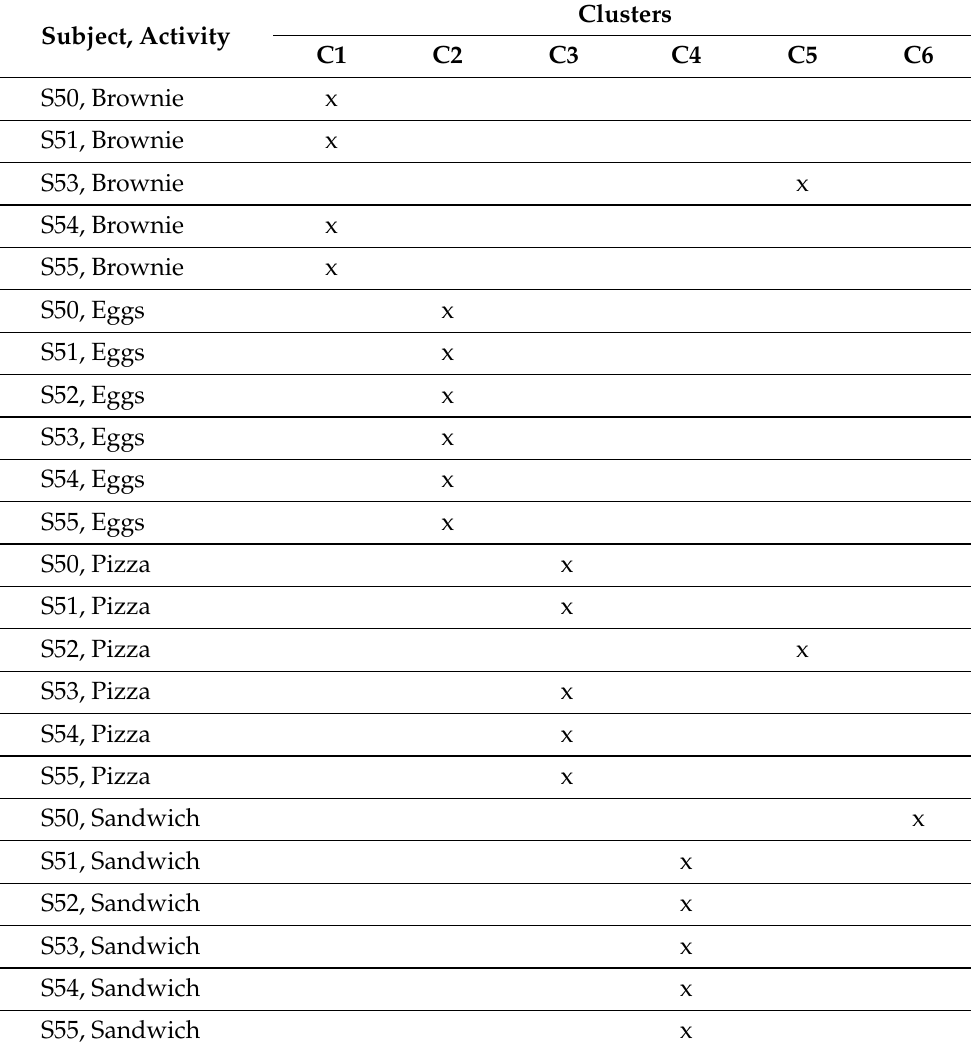
Table 2. Clustering results, with no prior assumption of the number of clusters, obtained by IBC1 algorithm using CMU-MMAC